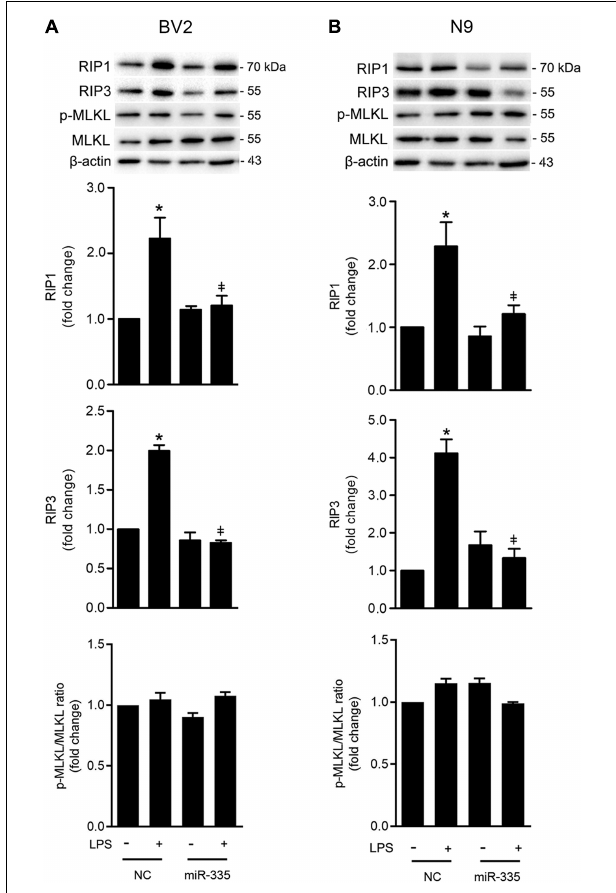
FIGURE 2 | Modulation of LPS-induced protein expression of RIP1 and RIP3 by miR-335. BV2 microglial cells (A) and N9 microglial cells (B) were transfected with pre-miR-335 or negative control (NC) for 24 h and then stimulated with LPS for additional 24 h. Total protein extracts were prepared for Western blot analysis of RIP1, RIP3, and p-MLKL/MLKL ratio. Representative immunoblots are presented. β -Actin was used as loading control. Values are expressed as mean ± SEM of three independent experiments. * p < 0.05 vs. NC; } p < 0.05 vs. NC exposed to